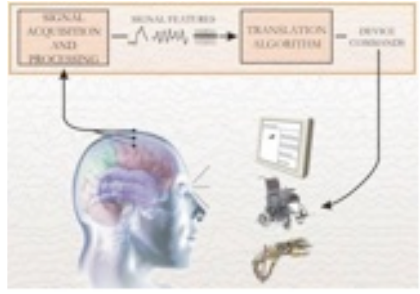
Figure 2. Healthcare Information Design: BCI 2000 Platform of Racing Car Game with